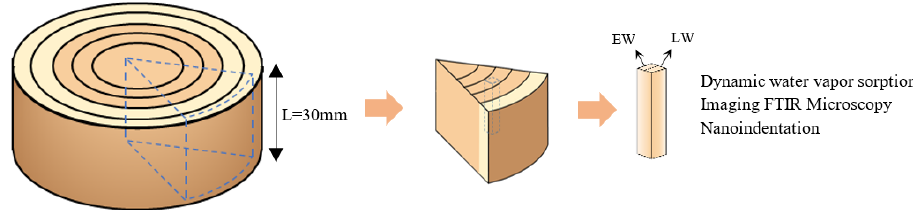
Figure 1. Wood sampled from disk of Larix kaempferi Carr.